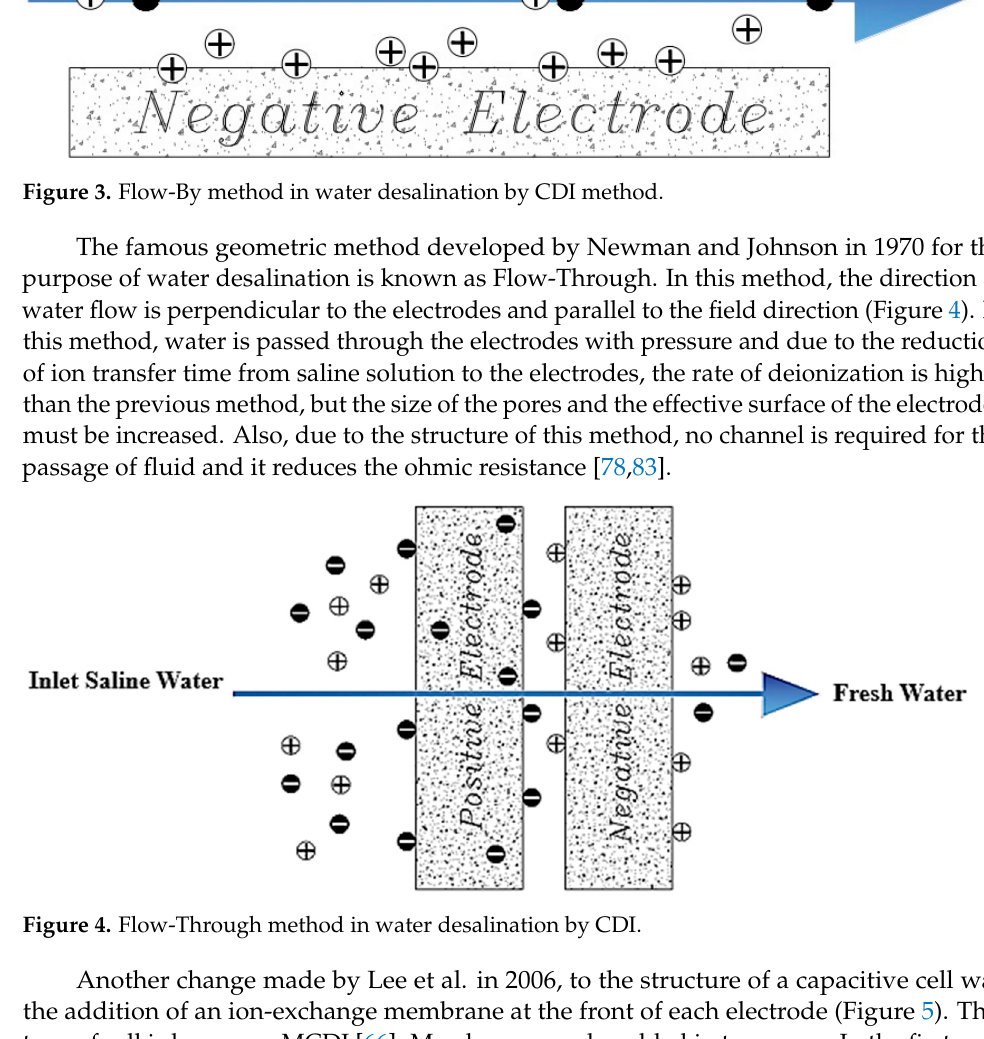
Figure 5. Ion exchange membrane in CDI cell. Another method known as electrostatic ion pumping has a completely different flow path for freshwater and condensed salt water [87]. The operation of this method is opened and closed by double alternating valves and controls the outlet flow [75]. The primary saline water is pumped from the top of the cell, and after passing through the electrodes, salt ions are absorbed and fresh water is generated at the bottom of the channel (Figure 6). After saturation, the electrodes are regenerated by a short circuit. During the regener- ation phase of the electrodes, the water flow path can be reversed, which causes a saline